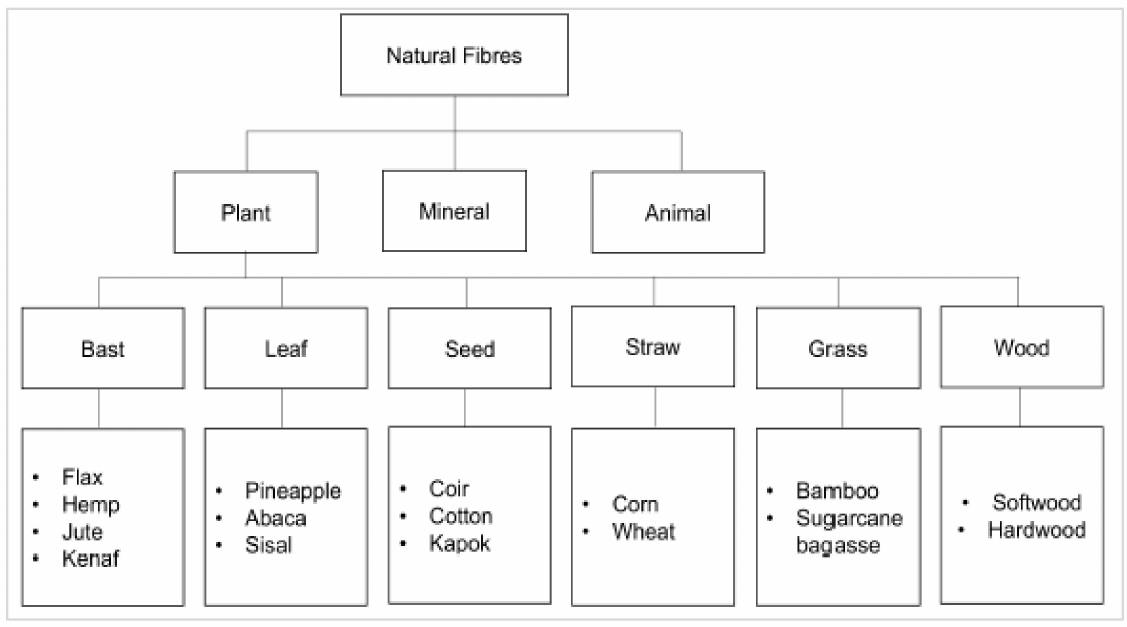
Figure 7. Source-based classification of natural fibers